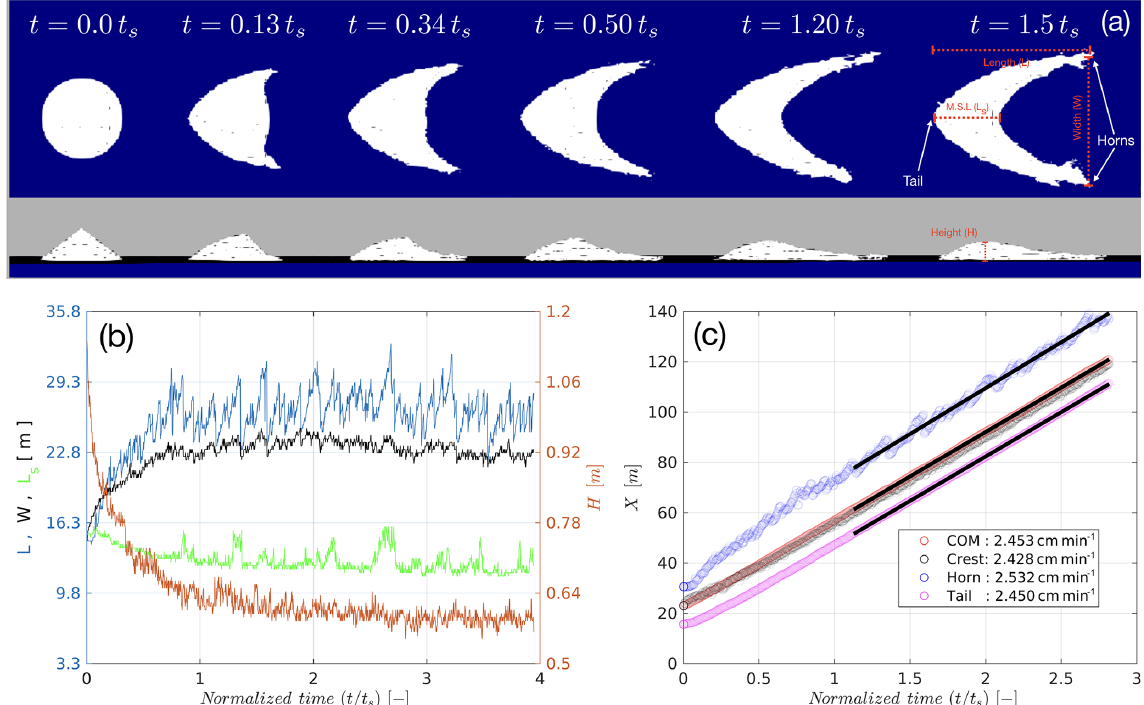
Figure 3. Morphodynamics of a solitary dune (case C20, high-wind scenario U 1m = 20 . 5ms − 1 ). (a) Visual representation of evolution from a cone pile to a barchan. The final image is annotated for identifying different descriptors of a barchan. (b) Evolution of the length (L), width (W) and the maximum streamwise length (L s ) of the barchan. (c) Different versions of calculating the dune speed using the displacement of the centre of mass (COM), tail, horns or crest of the dune.